Question: Looking at the figure, what chart type is it?
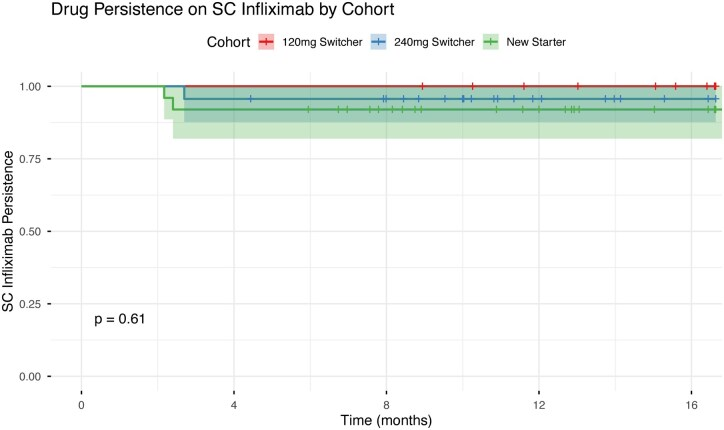
Answer: survival